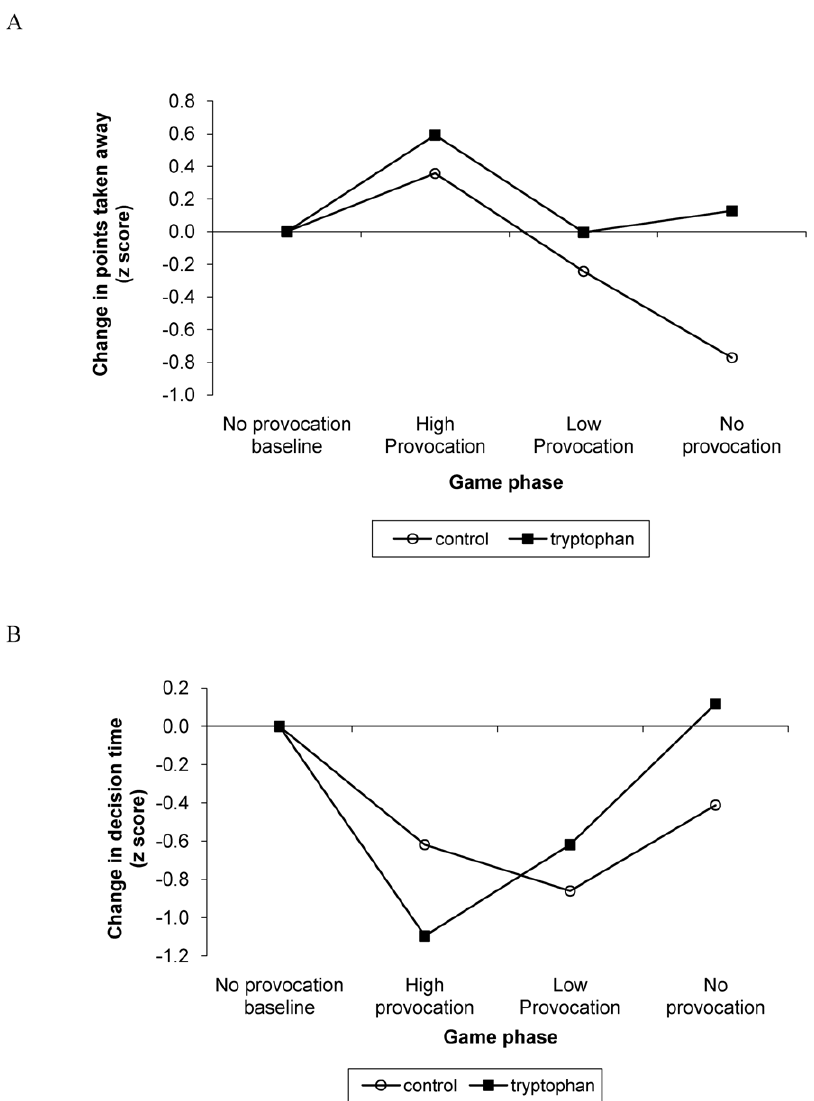
Figure 2. Points taken away (A) and decision time (B) at each phase of the competitive reaction time game. Values represent change (z score) in points taken away and decision time at each phase of the game, relative to the no provocation baseline.